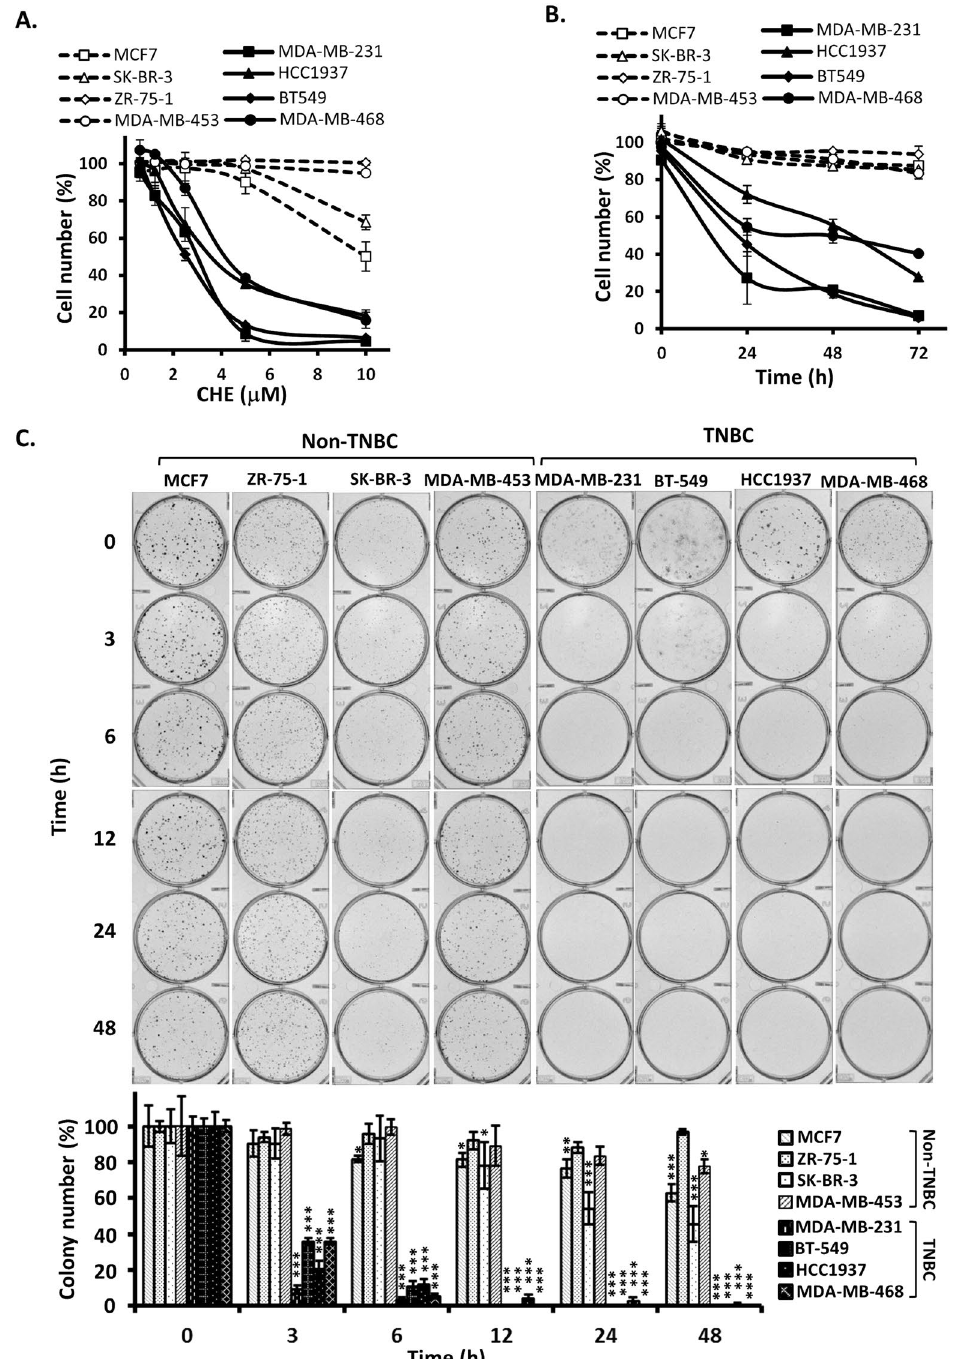
Figure 1. Chelerythrine selectively inhibits proliferation of TNBC cell lines in vitro . Four non-triple-negative breast cancer (Non-TNBC) cell lines (MCF7, ZR-75-1, SK-BR-3, MDA-MB-453) and four triple-negative breast cancer (TNBC) cell lines (MDA-MB-231, BT549, HCC1937 and MDA-MB-468) were used to determine the growth inhibition effect of chelerythrine (CHE). ( A ) Dose effect of chelerythrine treatment (72 hours) on the proliferation of non-TNBC cell lines compared with TNBC cell lines. The cell number at each chelerythrine concentration is represented as a percentage of control (no chelerythrine treatment). Average values are from three independent experiments performed in duplicate (n = 3). ( B ) Time course of chelerythrine treatment (5 μ M) on the proliferation of non-TNBC cell lines compared with TNBC cell lines. The cell number at each time point is represented as a percentage of control (no chelerythrine treatment). Average values are from three independent experiments performed in duplicate (n = 3). ( C ) Colony formation after treatment with chelerythrine (5 μ M) for indicated times. Representative colony formation assay plates are shown, which were quantified by counting colony number (n = 4). Data are shown as mean ± SD. P-values determined by Student’s t-test compared to control. * P < 0.05; ** P < 0.01; *** P <